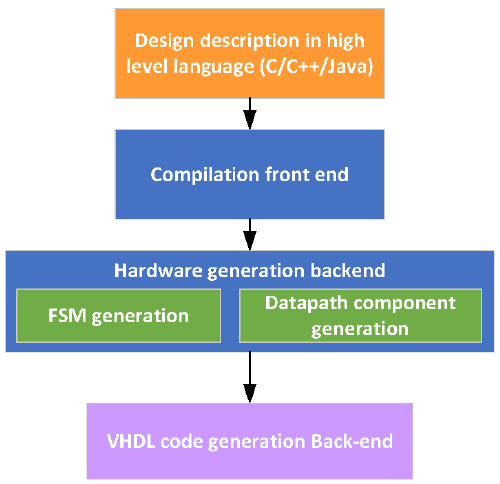
Figure 3. Conventional High-Level Synthesis (HLS)